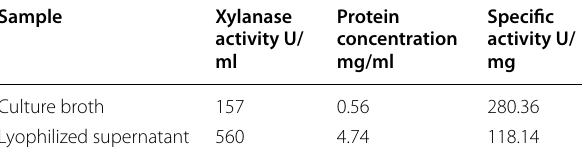
Table 1 Concentration of xylanase in culture broth by lyophilization